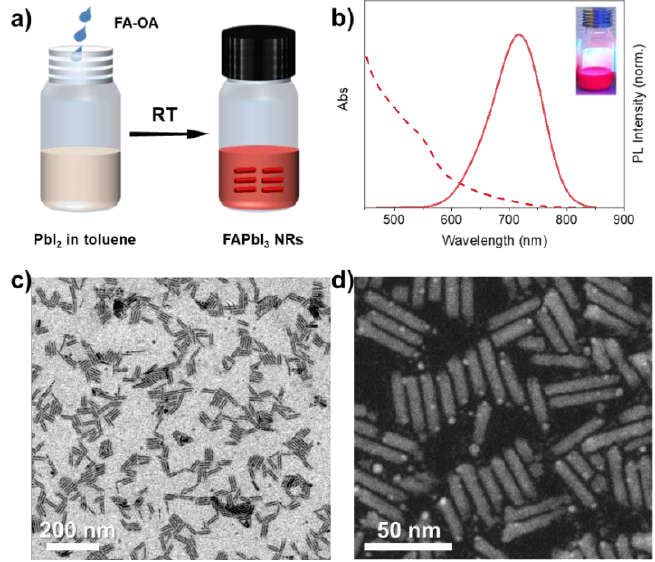
Figure 1. ( a ) Schematic illustration of the synthesis of perovskite nanorods (NRs) by addition of FA–oleate complex into the PbI 2 –ligand solution under ambient conditions. ( b ) Ultraviolet–visible (UV/Vis) absorption (dashed line) and photoluminescence (PL) spectra (solid line) of perovskite NRs. The inserted photograph shows the colloidal solution under UV illumination. ( c ) Transmission electron microscopy (TEM) image and ( d ) High-angle annular dark-field scanning transmission electron microscopy (HAADF-STEM) image of FAPbI 3 perovskite NRs.